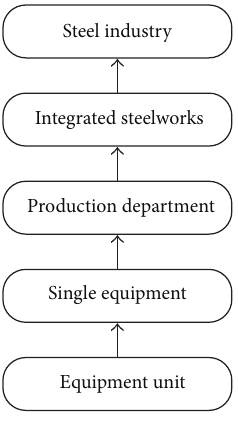
Figure 1: Five levels in energy conservation